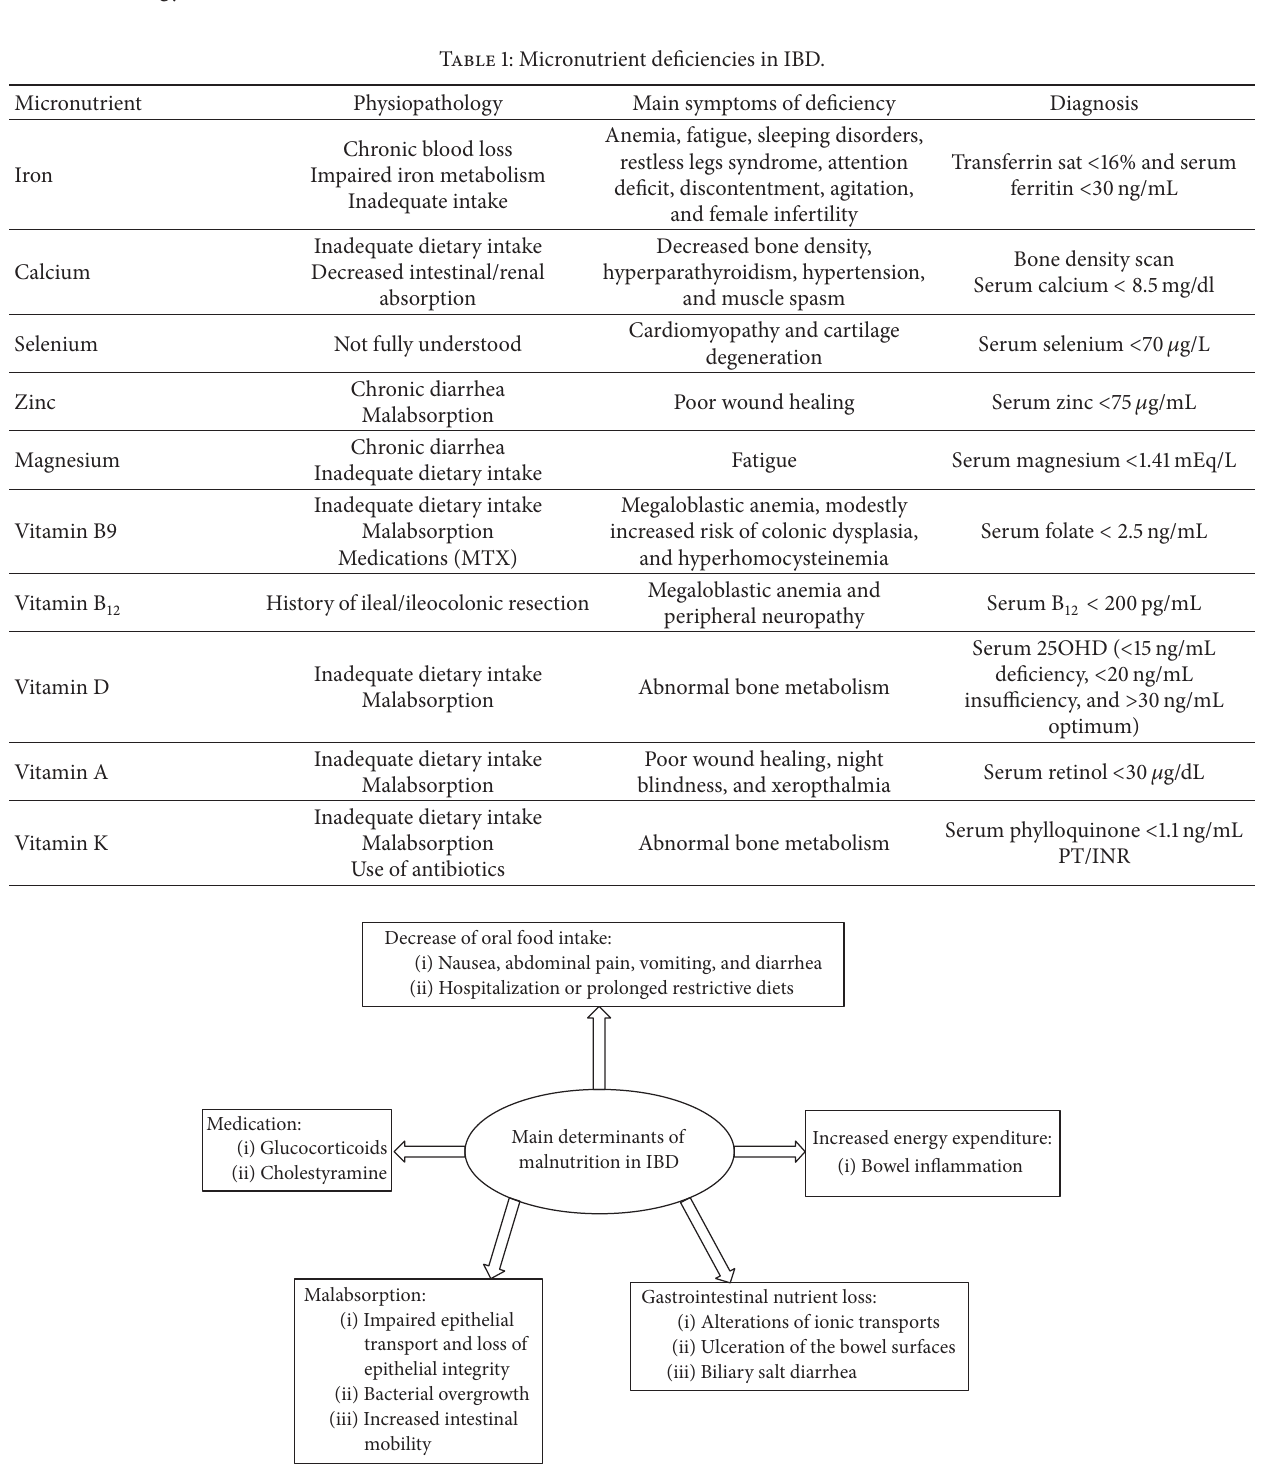
Figure 1: Main determinants of malnutrition in